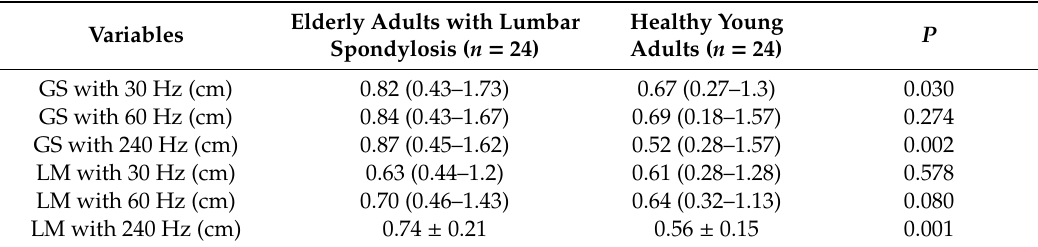
Table 2. Mean displacements of the center of pressure (COP) during the vibration trials for elderly adults with lumbar spondylosis and healthy young adults while standing on a balance